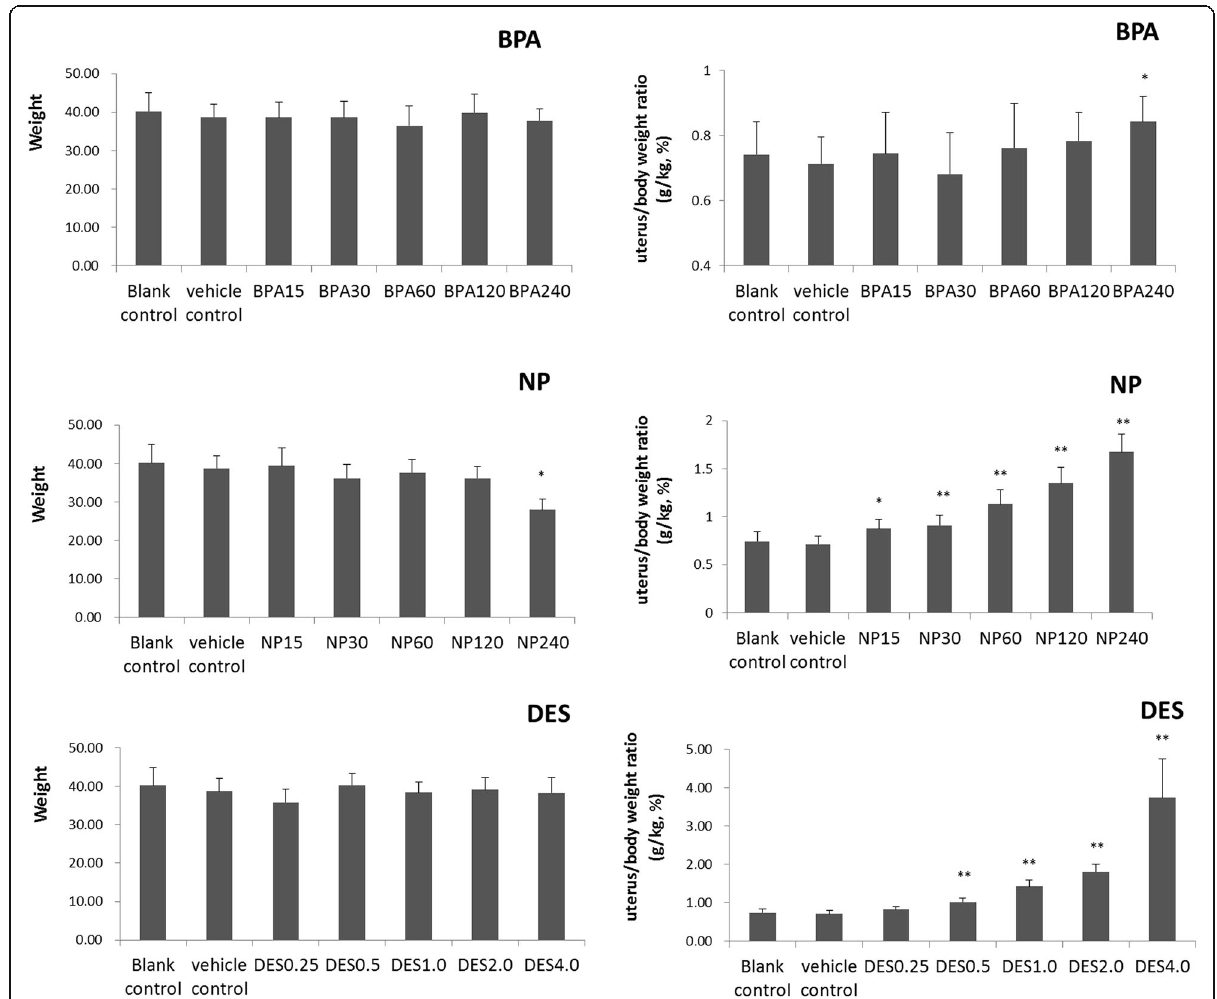
Fig. 2 Weight and uterus/body weight ratio of rats receiving the different chemicals. *: P < 0.05; **: P <